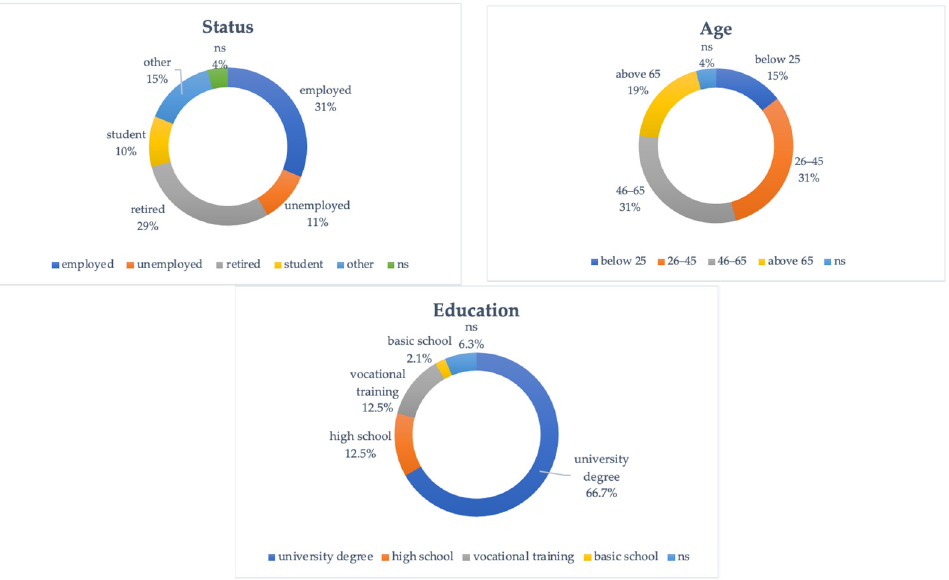
Figure 8. Age, status and education composition of the volunteers and gardeners sample surveyed (n = 48) N.S. = not specified.